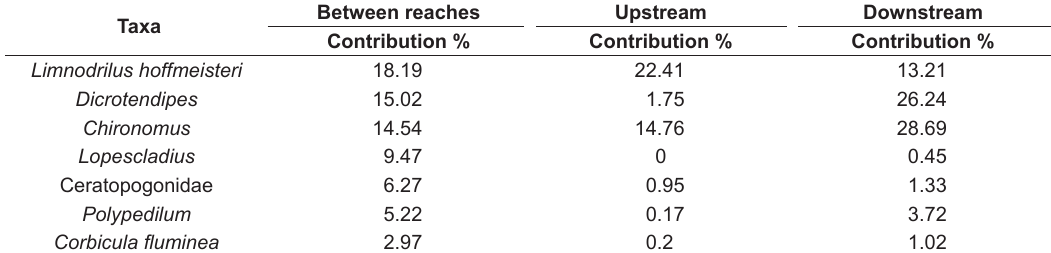
Table 3. Macroinvertebrates contributing to dissimilarity (SIMPER analysis) between upstream and downstream reaches of the weir, and among the sites in both reaches.